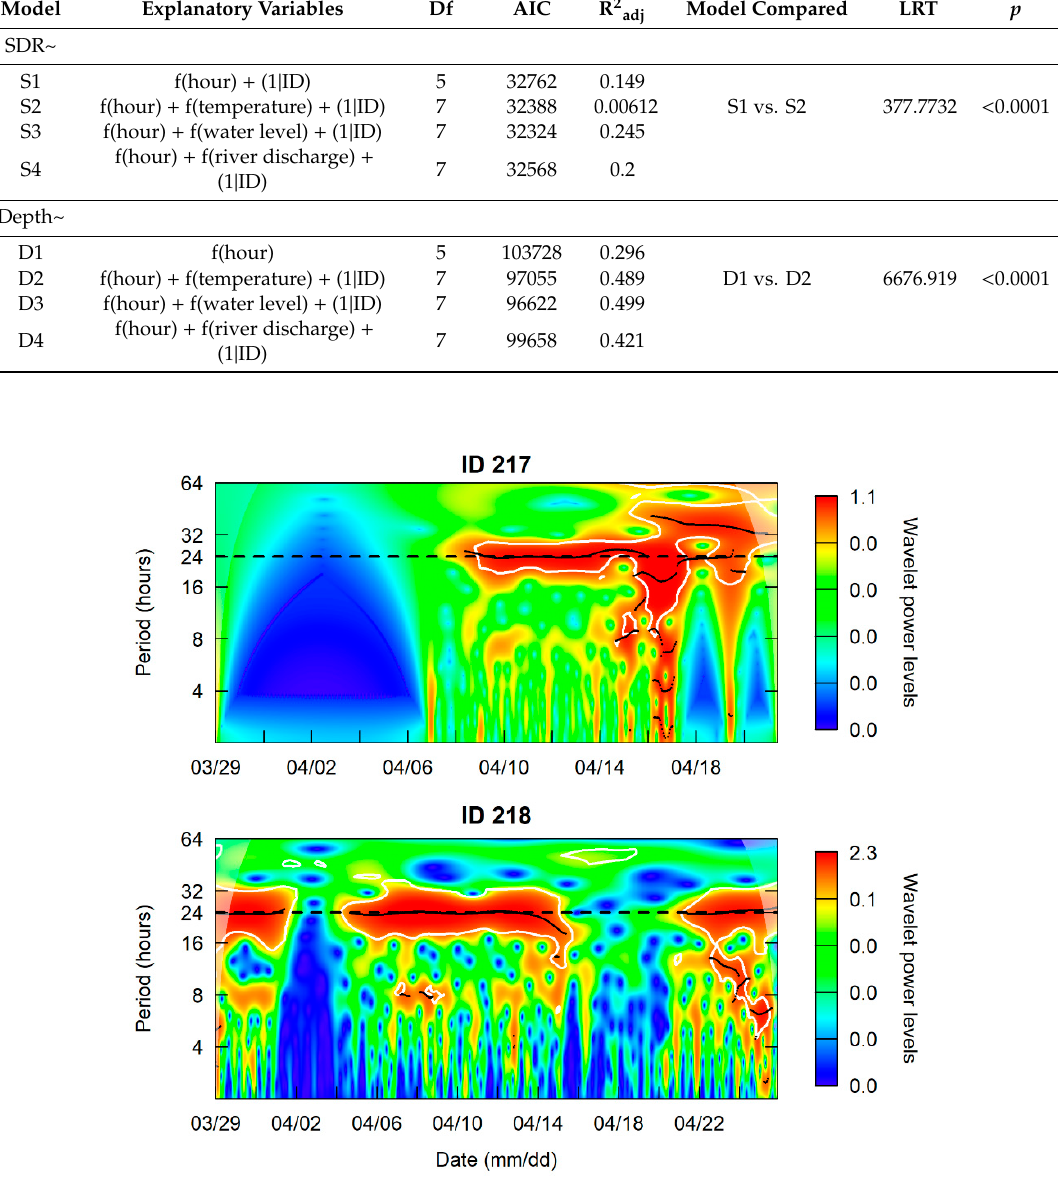
Figure 7. Wavelet spectra for depth data of common carp 217 and 218. Periodicities were detected in most of the tracking periods on a 24 h scale (horizontal dashed line). The thick contours delineated by white lines represent the 95% confidence level, and the scale bars represent the intensity of the time-frequency space over time.